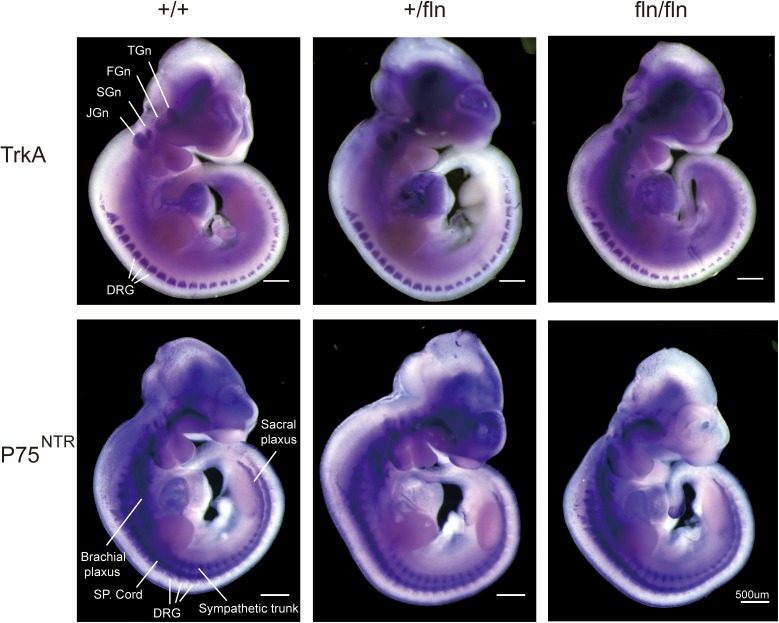
Expression of TrkA and P75NTR is normal in homozygous. Whole-mount in situ hybridization using antisense riboprobe for TrkA and P75NTR mRNA was performed on +/+ (n = 3), +/fln (n = 3), and fln/fln (n = 3) embryos at E10.5. TGn, trigeminal ganglion; FGn, facial ganglion; SGn, superior ganglion; JGn, jugular ganglion; DRG, dorsal root ganglion. Bar = 500 μm.